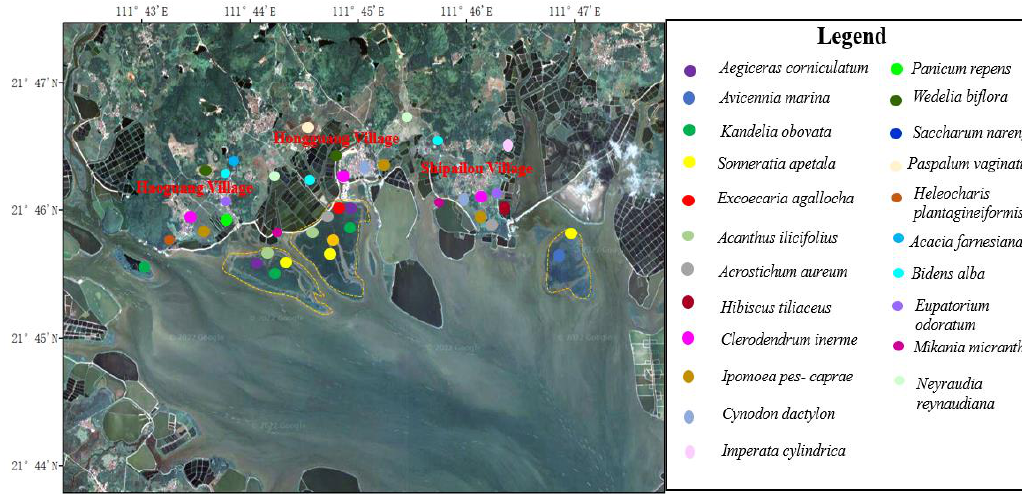
Figure 3. Distribution patterns of plant communities in the key plots.